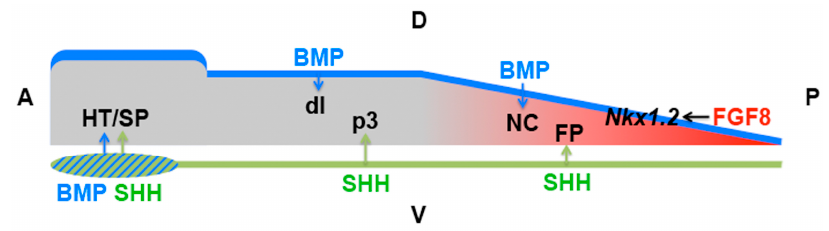
Figure 3. Differential competence of the elongating neural tube. Posteriorly, FGF8 (red) induces Nkx1.2 which endows neural tube cells with competence for floor plate (FP) formation in response to SHH (green) from the notochord (and for neural crest, NC, formation in response to BMPs). More anteriorly, in the absence of Nkx1.2 , SHH induces progenitors of ventral interneurons (p3) and BMPs (blue) induce dorsal interneurons (dI) [112]. In the forebrain, the prechordal mesendoderm expressed both BMP and SHH, resulting in the induction of the hypothalamus and subpallium (HT/SP) [120]. A, anterior; D, dorsal; P, posterior; V, ventral.